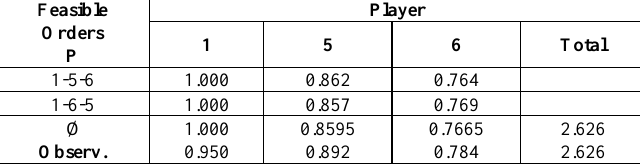
Table 9: Feasible orders for 12-brood game, good years. Feasible Orders